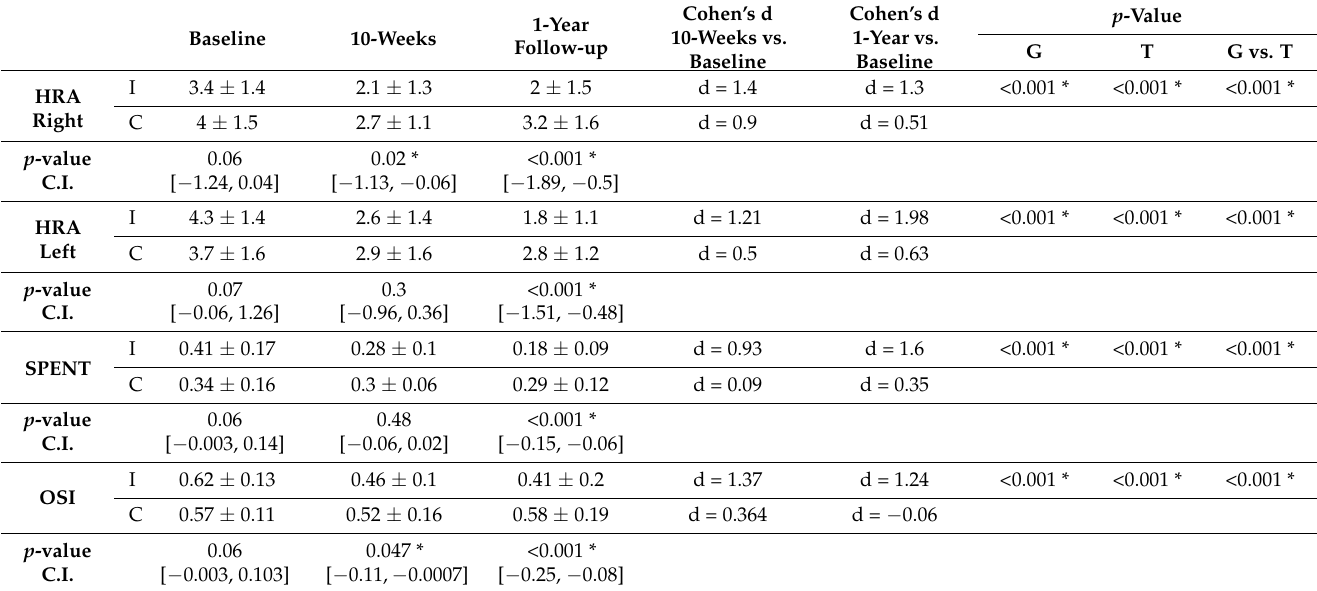
Table 4. The changes in posture control outcomes in experimental and control groups vs.